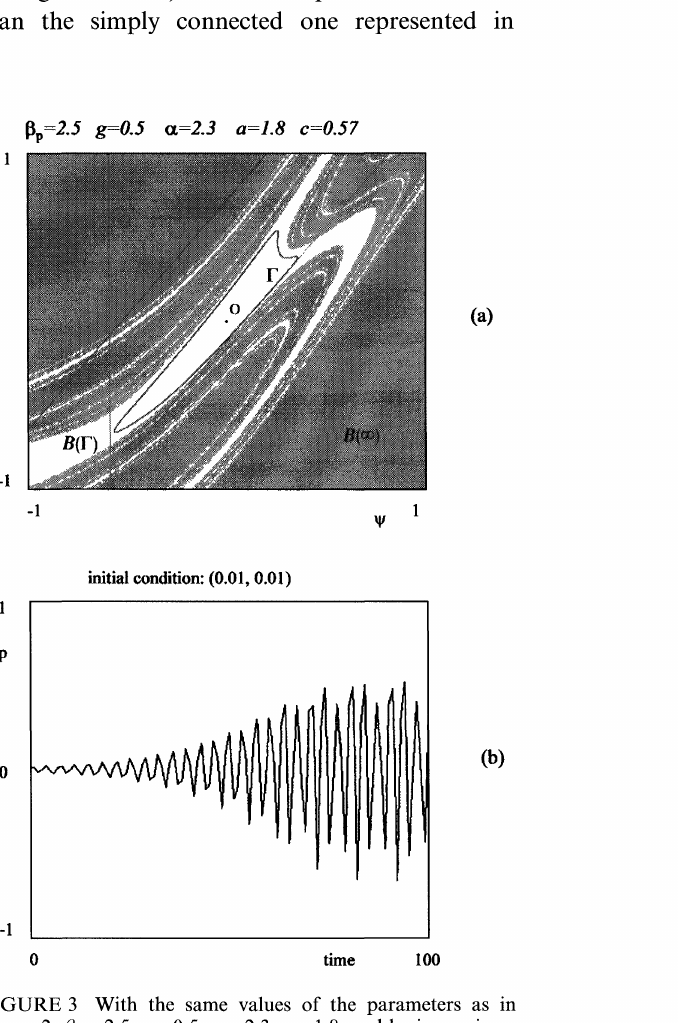
FIGURE 3 With the same values of the parameters as in Figure 2, tip--2.5, g =0.5, c- 2.3, a 1.8, and by increasing c further, the crossing of the Neimark-Hopf bifurcation curve is observed for c 0.5, which gives rise to an attracting closed invariant curve P, around the unstable focus O, represented together with its basin/3(F) in (a), obtained with c 0.57. The structure of the basin /3(F), which includes the whole area bounded by F, is the same as the one of the basin /3(0) in Figure 2f, and the dynamic effect of this local bifurcation is simply that of replacing the convergence to O with an oscillatory motion, as shown in (b), where the state variable p is represented as a function of